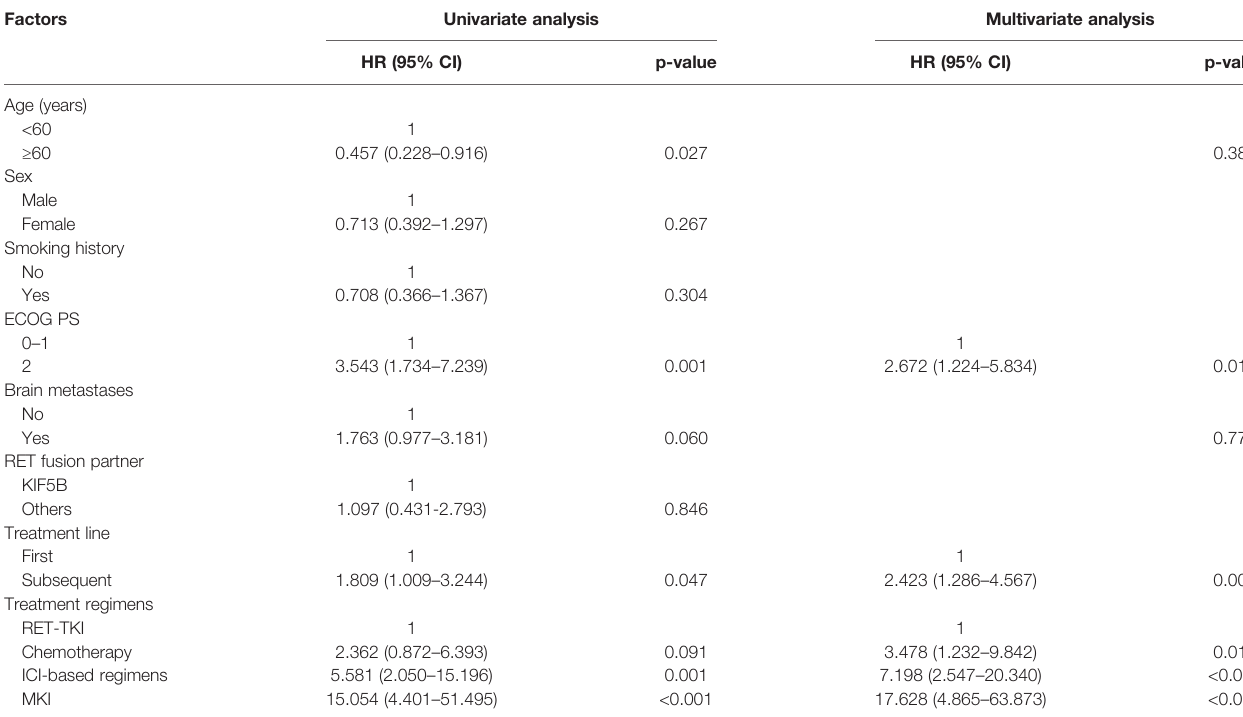
TABLE 3 | Univariate and multivariate Cox regression analyses for PFS in overall patients.